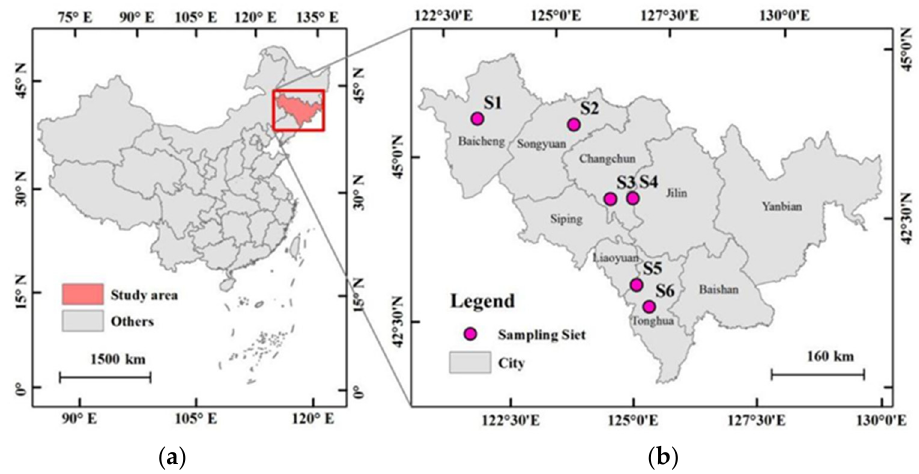
Figure 1. Map depicting the location of the sampling sites in Jilin Province. ( a ) Location of Jilin Province in China ( b ) Location of 6 sampling points in Jilin Province. Table 1. Site description of study sites in Jilin Province.